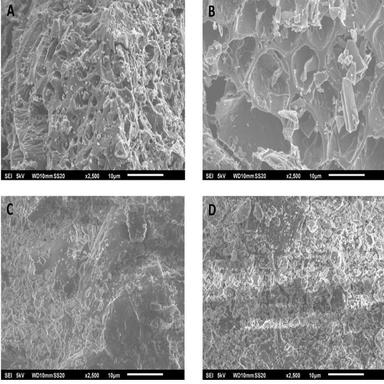
Scanning electron microscopy (SEM) images at x2,500 magnifications of A) biochar from red spruce pellets (BCSP), B) biochar from grapevine pruning residues (BCGV), C) hydrochar from urban pruning residues (HCUP) and D) hydrochar from the organic fraction of solid urban wastes (HCSU).